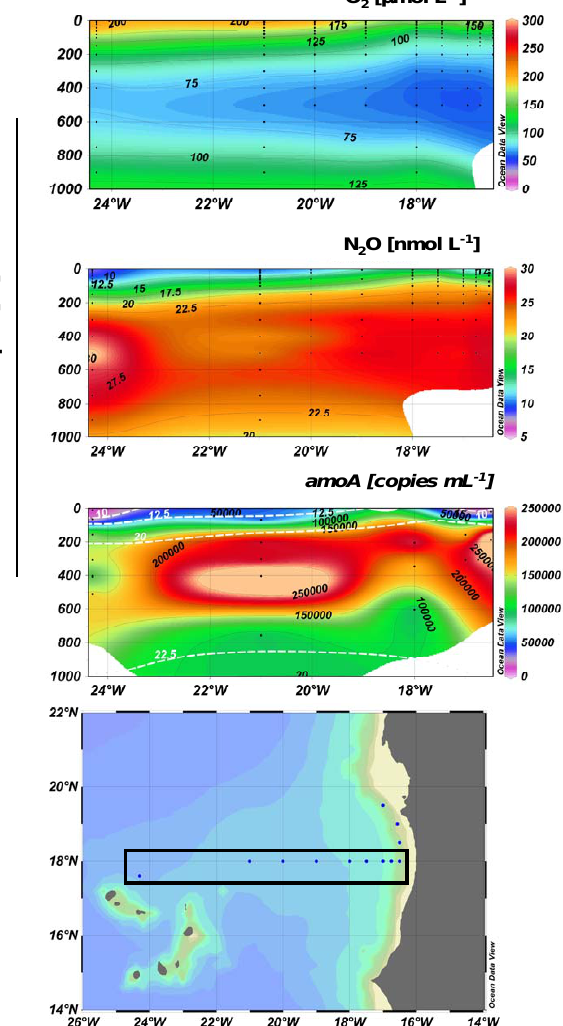
Fig. 3. Distribution of O 2 [µmoll − 1 ], N 2 O [nmoll − 1 ] and archaeal amoA [copiesml − 1 ] along 18 ◦ N in the ETNA, detected during the cruise P399. Archaeal amoA abundances are overlaid by the de- tected N 2 O concentration (dashed white